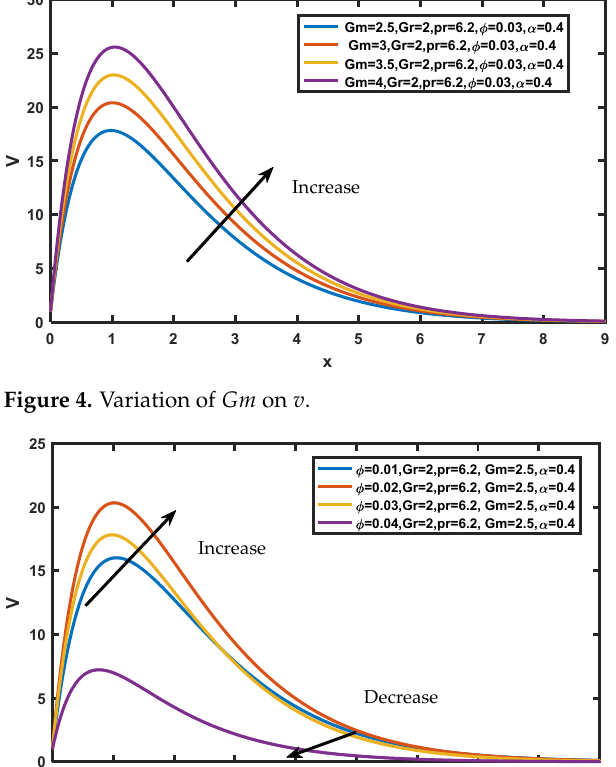
Figure 5. Variation of  in v .